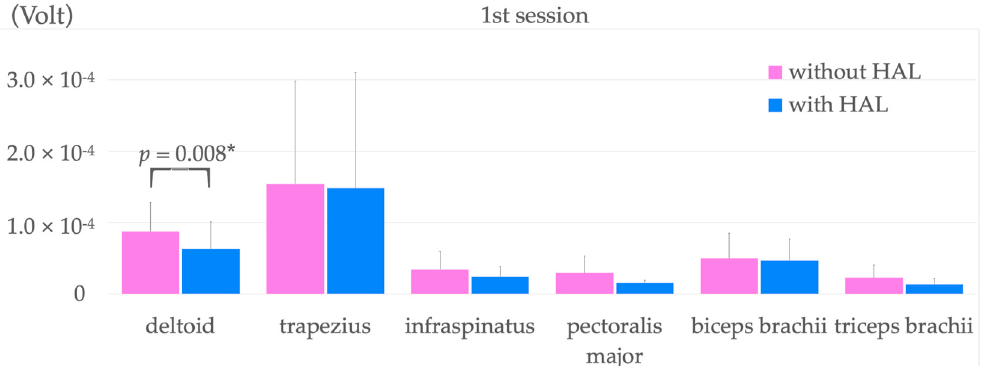
Figure 4. Comparison of surface EMG activity during upper limb raising before and after HAL application in the first training intervention. * p < 0.05. HAL, hybrid assistive limb.